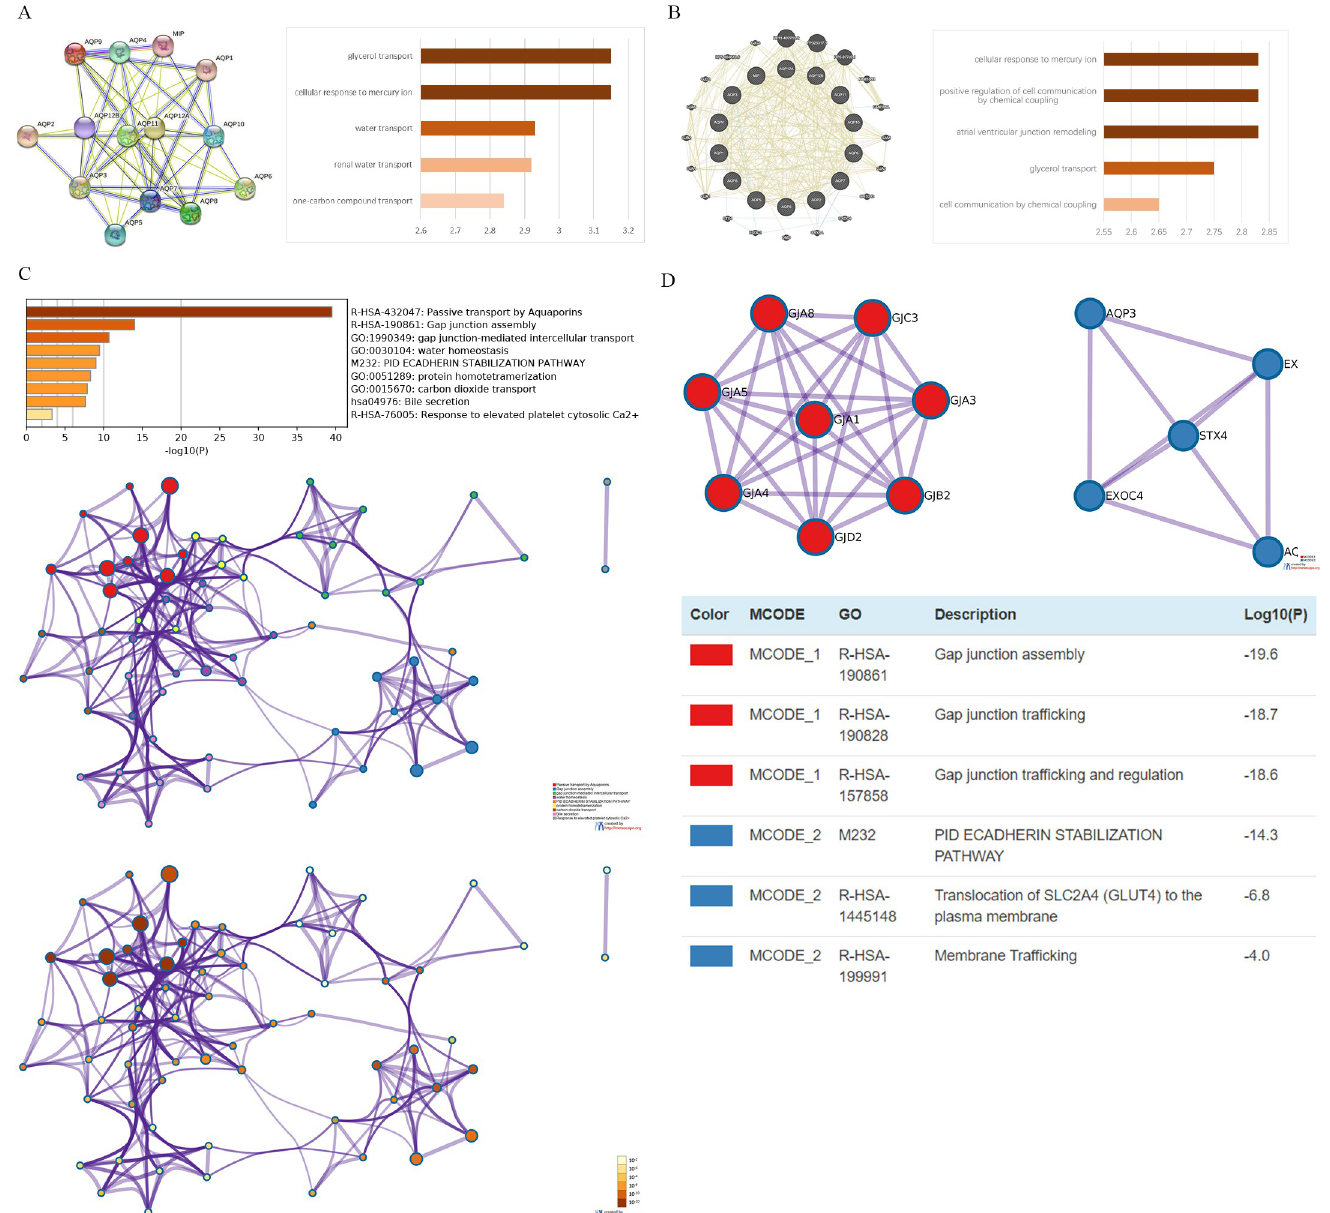
Fig 6. The enrichment analysis of AQPs and their similar genes in ccRCC (STRING GeneMANIA Metascape). ( A ) The PPI network and biological process (BP) enrichment analysis of AQPs were constructed through STRING (top5). ( B ) The PPI network and BP enrichment analysis of AQPs and 20 most functionally related genes were constructed through GeneMANIA (top5). ( C ) The gene ontology (GO) enrichment analysis of AQPs and 20 most functionally related neighboring genes in ccRCC (p < 0.05), each GO term is colored by cluster and p-values. ( D ) The two most significant mCODE components and independent functional enrichment analysis were identified through AQPs and 20 most functionally related neighboring